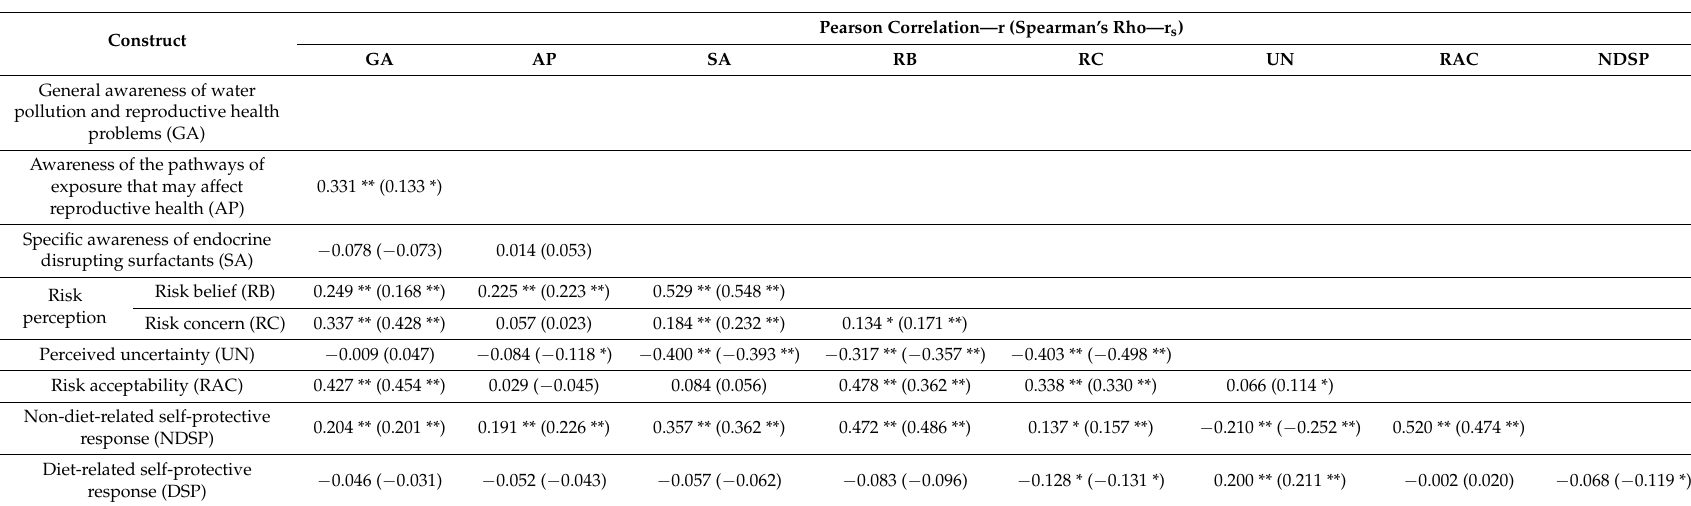
Table 4. Bivariate correlations ( n =